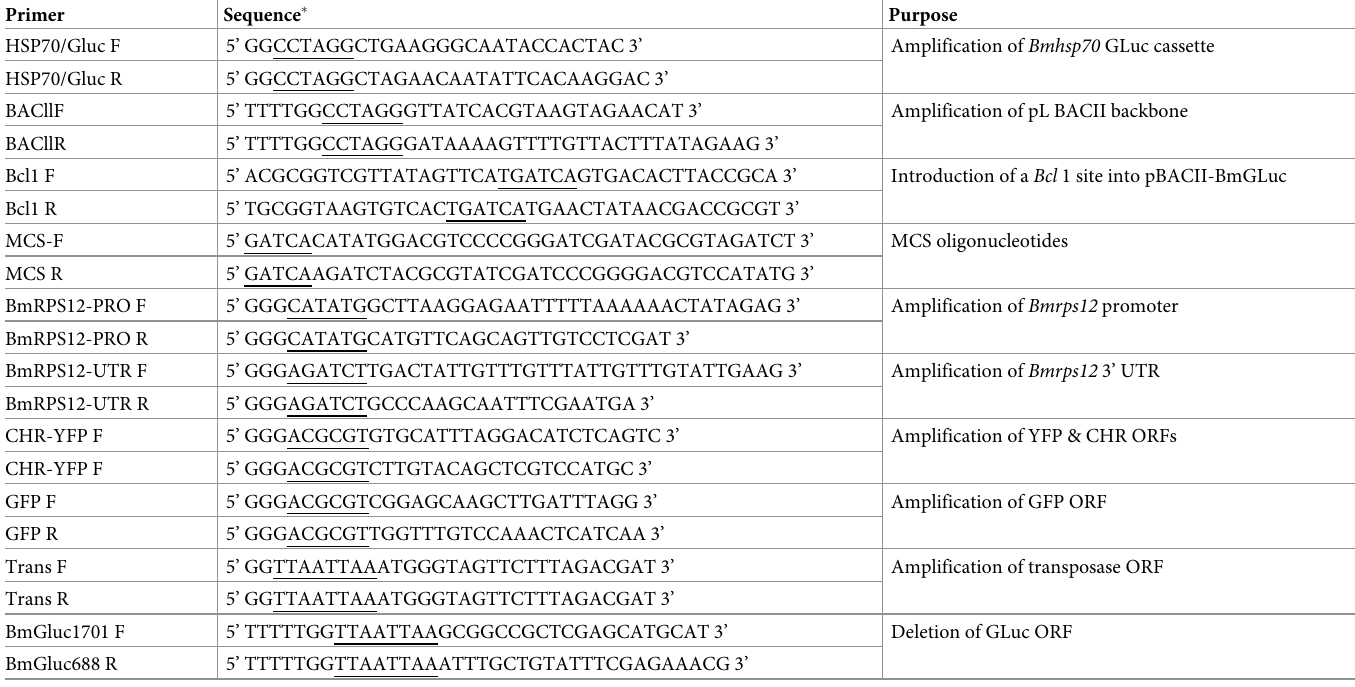
Table 1. Primers used in the production of the piggyBac plasmids. Primer Sequence